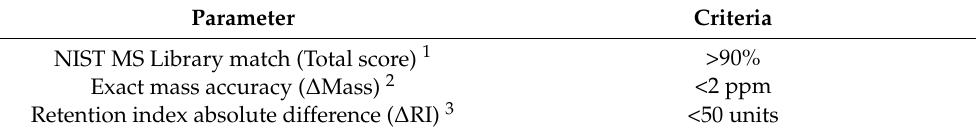
Table 1. Criteria used for the tentative identification of unknown